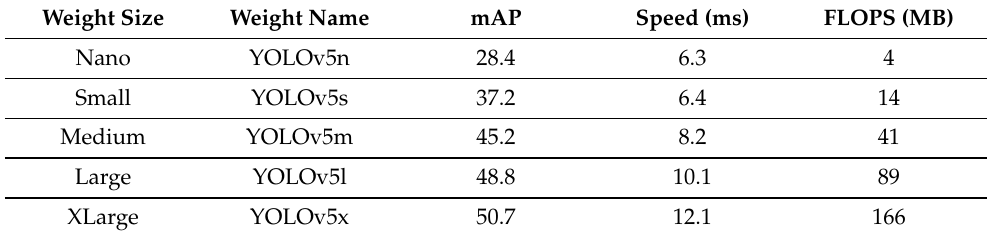
Table 1. Yolo v5 weights details